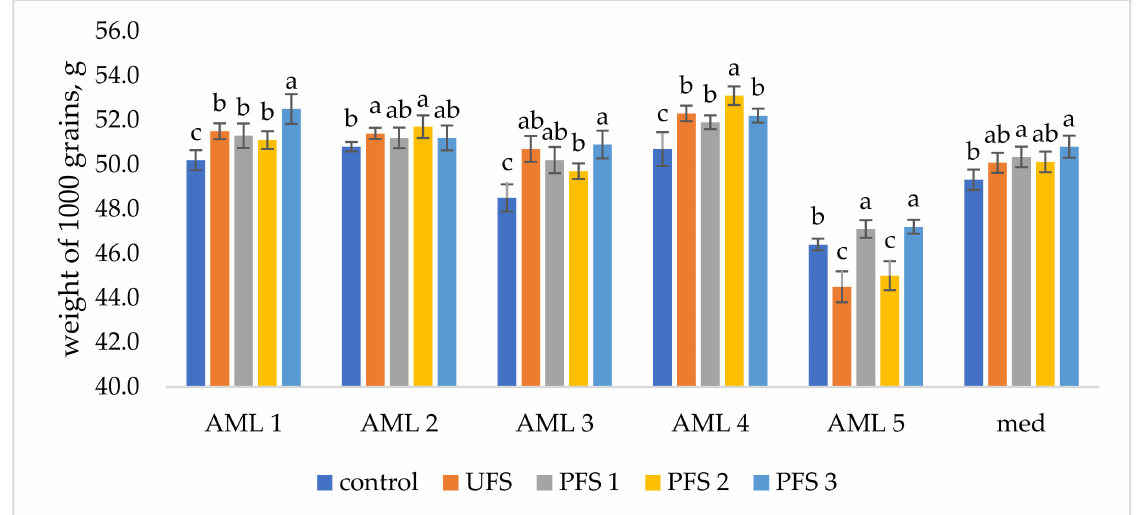
Figure 6. Weight of 1000 grains of winter wheat in the